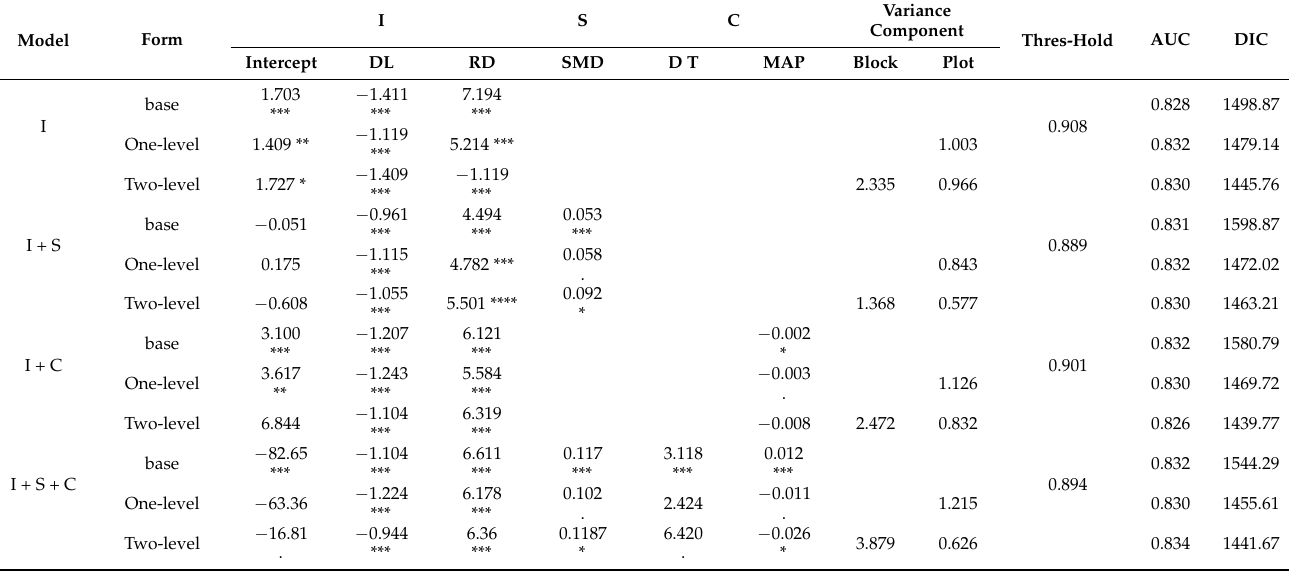
Table 4. Parameter estimates of tree survival models from fixed-effect (non-hierarchical: Base, one-level, and two-level random effects) models using the Bayesian